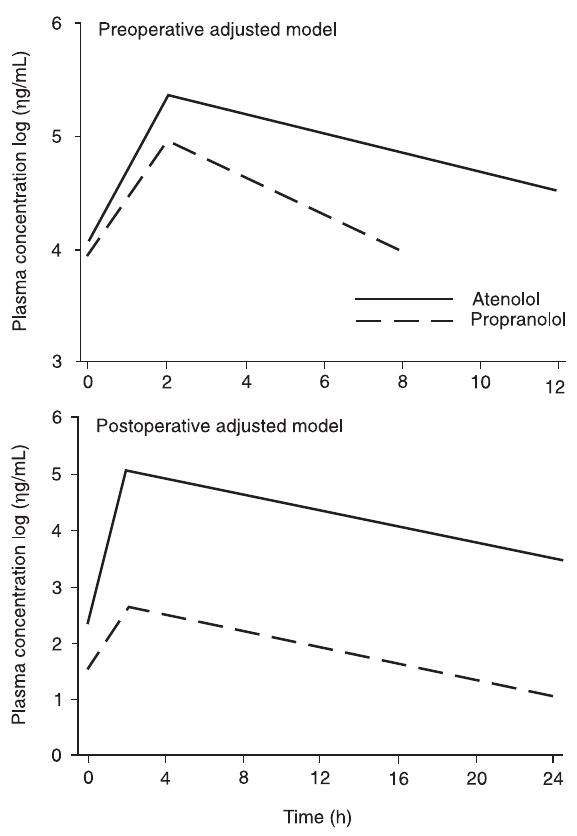
Figure 2. Adjusted model of log plasma concentration of atenolol (continuous line) and propranolol (dashed line) during the preop- erative and postoperative periods of coronary artery bypass graft surgery with cardiopulmonary bypass. The slopes of the decaying phase of the log plasma concentration of atenolol pre- and postoperatively were -0.08 and –0.11, respectively. For pre- and postoperative decaying concentrations of propranolol, the slopes were -0.16 and -0.08, respectively.